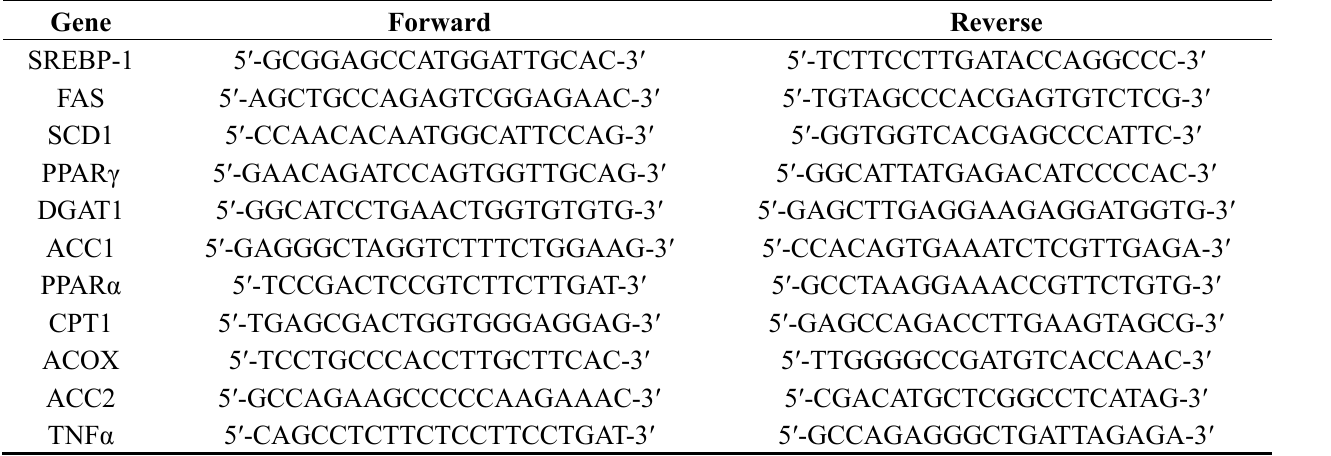
Table 1. Gene-specific primers used for real-time